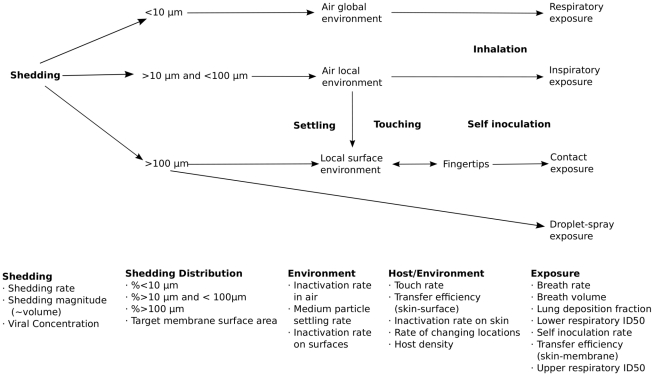
Schematic of pathogen flow through the environment with specific events in bold resulting in respiratory, inspiratory, contact or droplet exposure.Relevant governing parameters of transmission are listed below each phase. Viral inactivation occurs in the air, on surfaces, and on fingertips (not explicitly shown). Moving from the left to the right of the diagram, viral excretion magnitude is determined by the shedding rate, volume, and concentration. Where these viruses go is determined by the size of the particle they adhere to during excretion. Based on cough particle size distribution data, these are divided proportionally. Viruses on small particles are well mixed, and are assumed to either inactivate or be inhaled (respiratory exposure) before settling would occur. Viruses on medium particles may either inactivate, settle to the local surfaces, or be inhaled (inspiratory exposure). Some viruses on large particles may be utilized initially in droplet exposure, proportional to the target facial membrane surface area multiplied by the number of susceptible collocated with the shedder. Viruses on larger particles not utilized in droplet exposure is assumed to settle immediately to the local surface environment. Here it may inactivate, or be picked up on fingertips. Once on fingertips, the virus may inactivate, be deposited back to a surface environment, or be used in contact exposure via self-inoculation. Respiratory exposure assumes lower respiratory penetration and uses an ID50 specific to this region. Inspiratory, droplet, and contact exposure assumes the potential for infection only occurs in the upper respiratory tract and all use the same ID50 specific to this region. For simplicity, we assume exponential dose-response relationship.